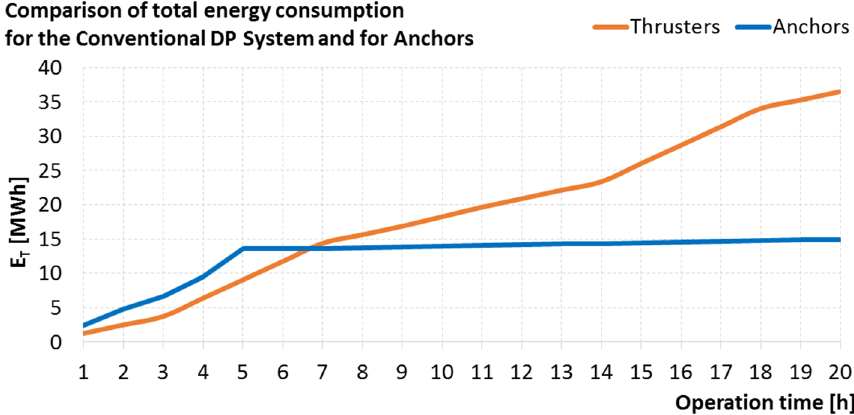
Figure 19. Comparison of energy consumption for both systems.